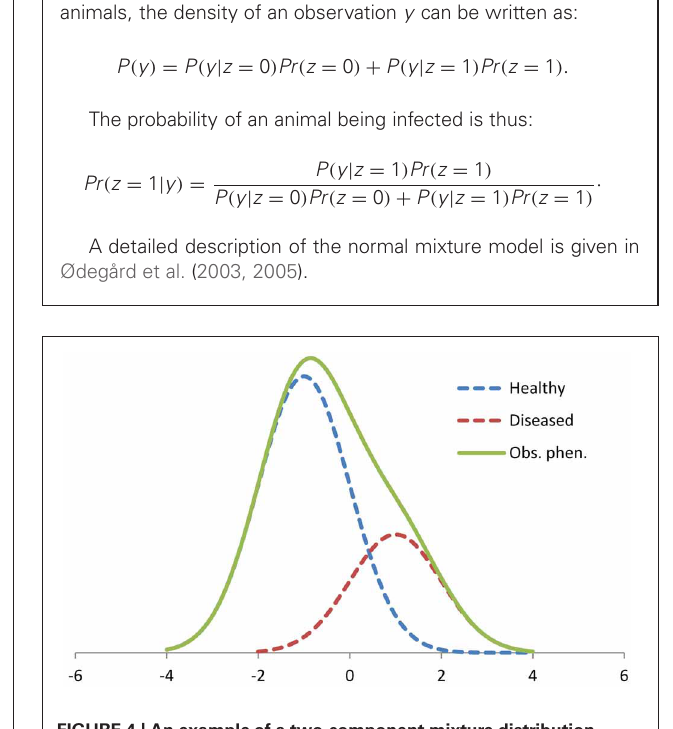
FIGURE 4 | An example of a two-component mixture distribution. The dotted lines are the unobserved distributions of non-infected “healthy” individuals (70% of the observation) with ∼ N ( − 1.0, 1.0) and infected “diseased” individuals (30%) with ∼ N (1.0, 1.0). The solid line represents the resulting distribution of the observed phenotypes. Trait values are given on x -axis and the frequencies of observations on y